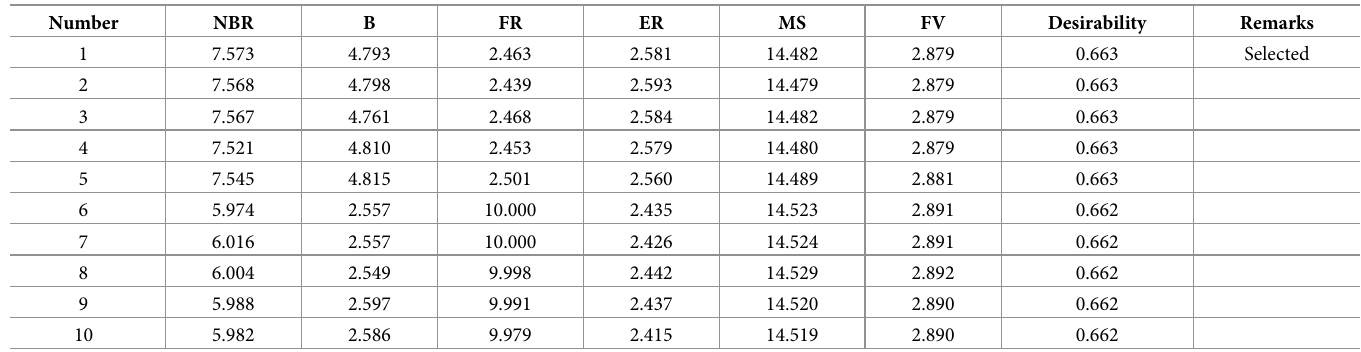
Table 10. Multi response optimization solutions.